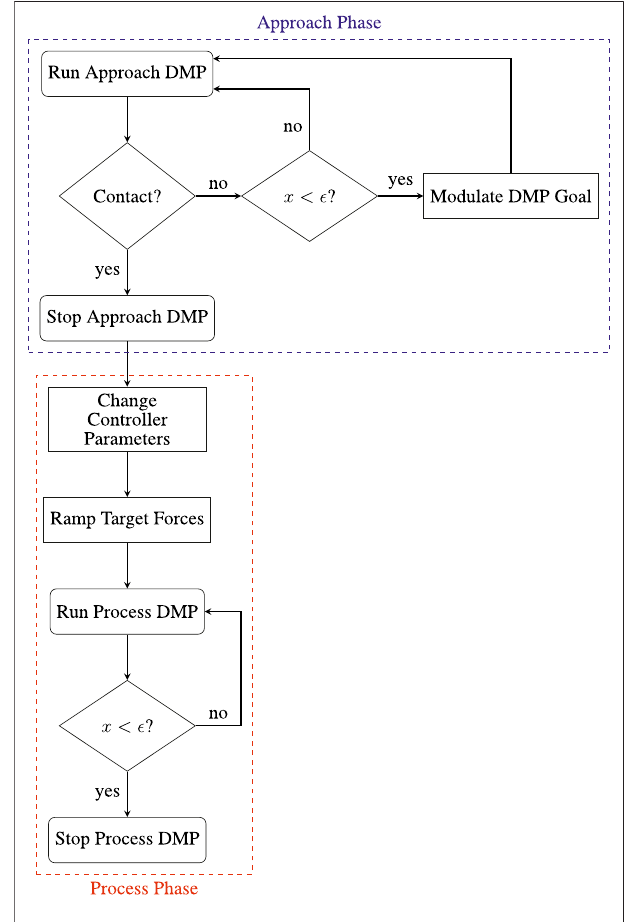
FIGURE 4 | Block diagram of segmented execution fl